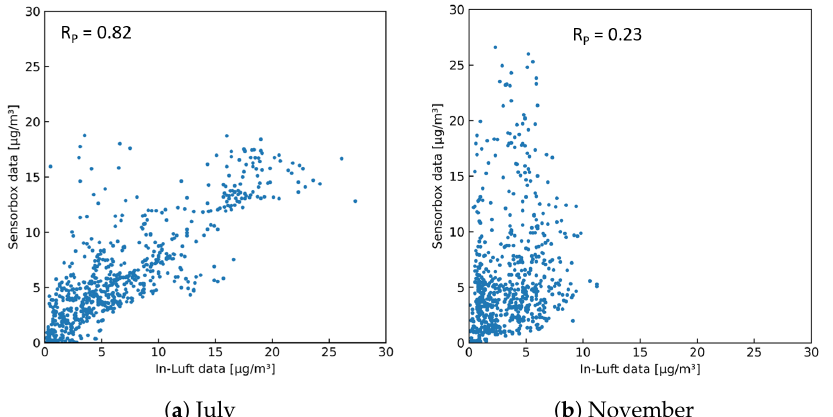
Figure 25. PM 10 hourly mean data recorded with mobile pilot sensor-box 8 located in Cham compared to hourly mean data recorded at the in-luft station located in Rigi, Seebodenalp. ( a ) N = 712, R P = 0.82, R S = 0.81; ( b ) N = 696, R P = 0.23, R S =